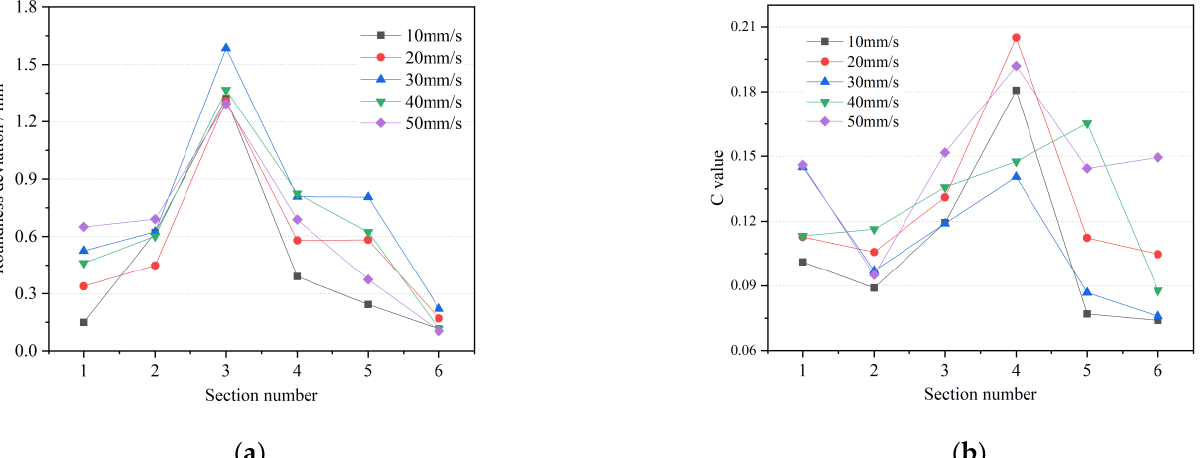
Figure 10. Forming quality under different chuck axial speeds ( a ) roundness deviation; ( b ) wall thickness uniformity.